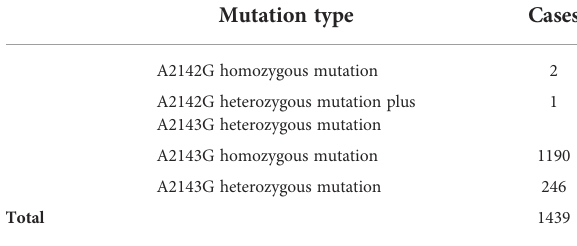
TABLE 2 Cases of different mutation types in 23S rRNA of H.